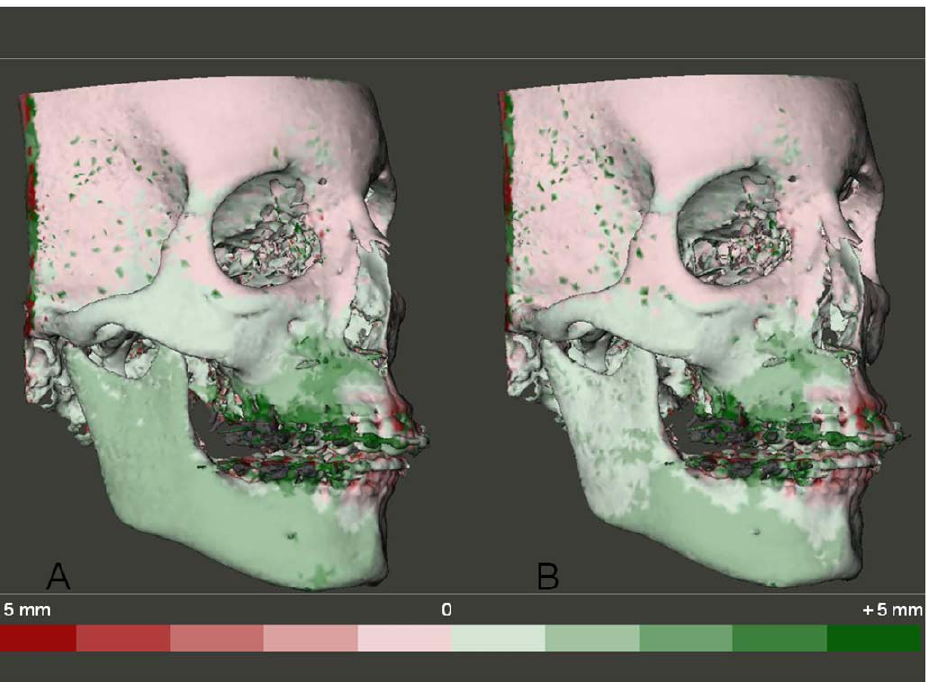
Figure 5. Color coded distance maps to visualize treatment changes following two CBCT scans superimposition. The green color indicates that the superimposed model is in front of the original model and red color indicates the opposite. Each color graduation is 1 mm. (A) models registered on the anterior cranial base. (B) same models registered on the left zygomatic arch.